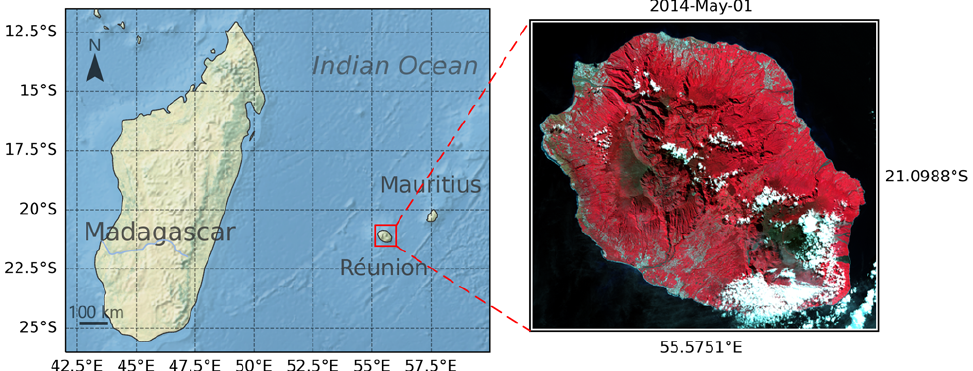
Figure 3. Study area location and overview of the Reunion Island dataset. The Landsat image uses a false color combination of near-infrared, red, and green